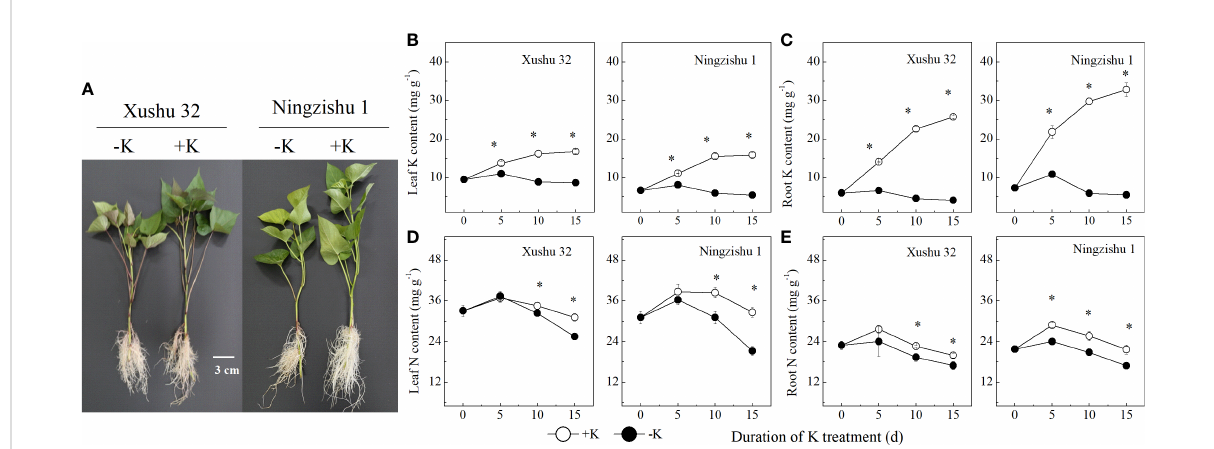
FIGURE 1 Difference in the sensitivity to K de fi ciency between the two sweet potato genotypes (low-K-tolerant “ Xushu 32 ” and low-K-sensitive “ Ningzishu 1 ” ). (A) Phenotypic difference of sweet potato plants during K de fi ciency ( − K) and K suf fi cient (+K) treatments for 10 days. (B, C) leaf and root K